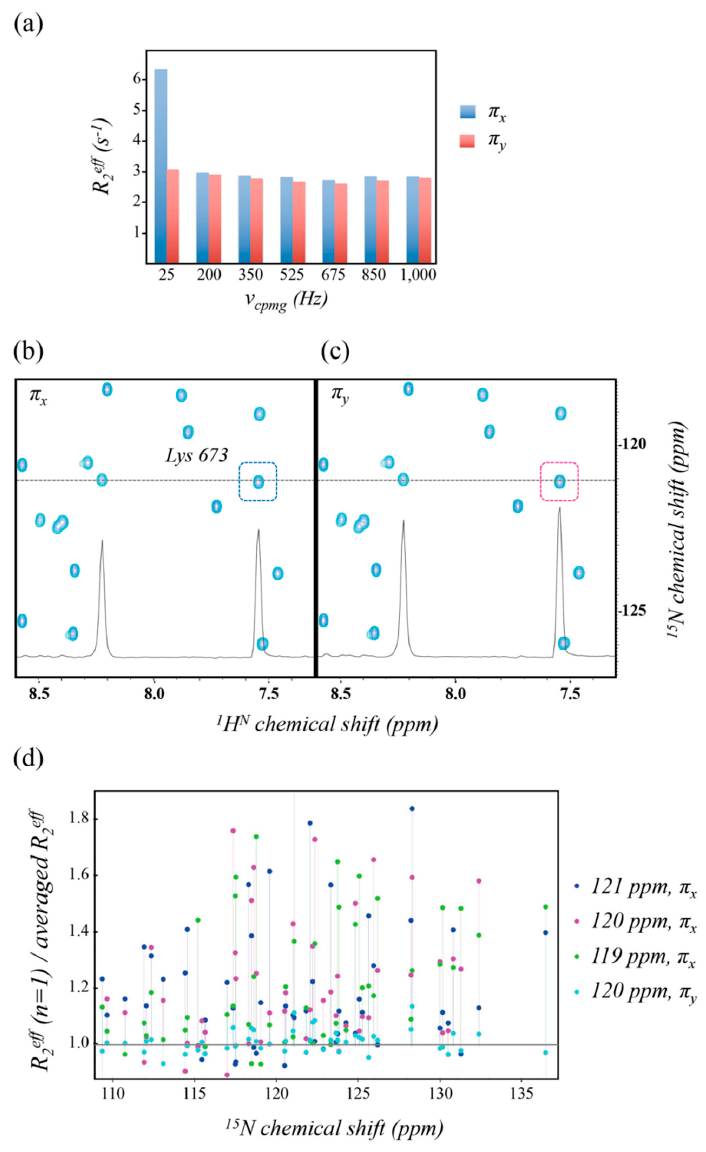
Figure 2. ( a ) Comparison of rd profiles of Lys–673 of [ 15 N]-ChiA1. The data were obtained with the 15 N π pulse in the middle of the U-element applied along the x -axis (blue) and y -axis (red) in a TROSY-based rc 15 N spin CPMG rd experiment. The vertical axis stands for the effective transverse relaxation rates ( R 2eff ), estimated from the intensity ratio of each amide 1 H/ 15 N correlation peak obtained in the presence of the CPMG pulse trains (40 ms in total) to the corresponding one obtained in their absence. The horizontal axis stands for the CPMG frequency, ν cpmg = 1/(4 δ ); ( b , c ) Two-dimensional 1 H/ 15 N TROSY–HSQC planes measured with the 15 N π pulse in the U-element applied along the x -axis ( b ) and y -axis ( c ), respectively, at the lowest ν cpmg value (25 Hz, a spin-echo repetition count n of 1). The amide peaks of Lys–673, exhibiting the abnormal value as shown in ( a ), are boxed. One–dimensional cross-sections along the 1 H N dimension at the 15 N frequency indicated by the dashed lines are shown in the 2D spectra; ( d ) Artifacts observed in the spectra obtained with different 15 N carrier frequencies. The horizontal axis represents the amide 15 N chemical shifts of ChiA1. The vertical axis represents the ratio of R 2eff obtained at n = 1 ( ν cpmg of 25 Hz) to the average of the remaining six R 2 eff values obtained at n = 8 (200), 14 (350), 21 (525), 27 (675), 34 (850), and 40 (1000 Hz) for each 1 H/ 15 N correlation. Blue, magenta, and green points show the data obtained with the 15 N carrier frequency placed at 121, 120, and 119 ppm, respectively, and with the central π pulse in the U-element applied along the x -axis. Cyan points indicate the data with the π pulse applied along the y -axis and the carrier frequency set at 120 ppm. The experiments were performed using a Bruker spectrometer (800